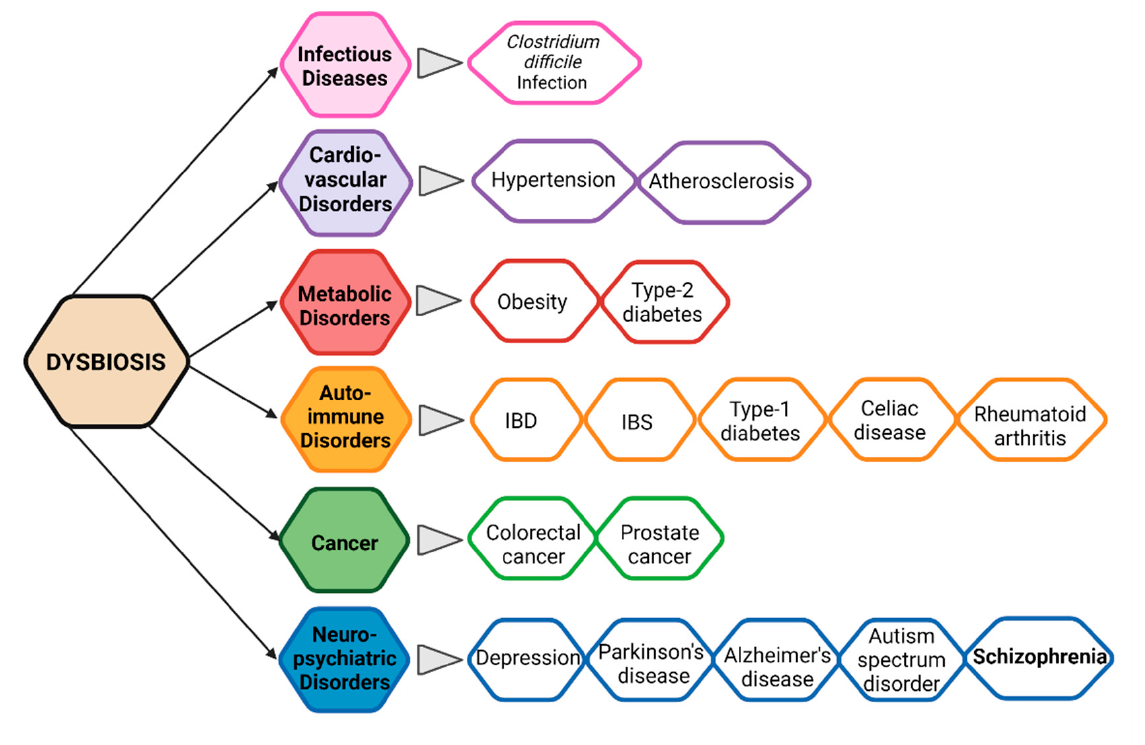
Figure 2. Gut microbial dysbiosis-related disorders.